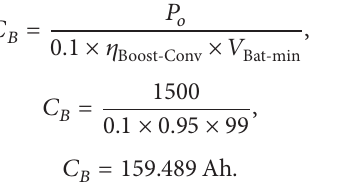
Figure 17: Fuel cell stack.